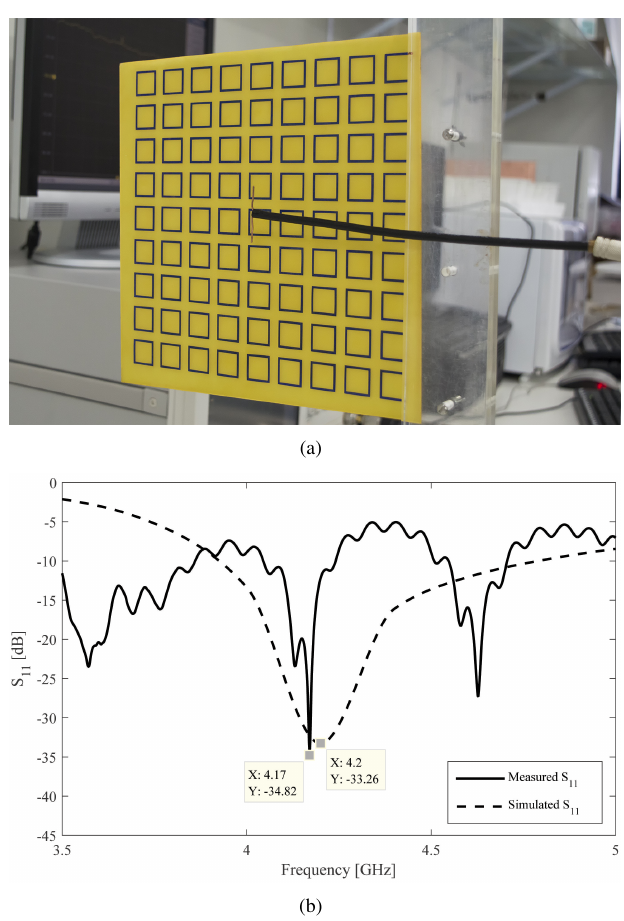
Figure 7: Comparison between measured and simulated transmission for the FSS. Figure 8: (a) Measurement Process; (b) Results for the sim-